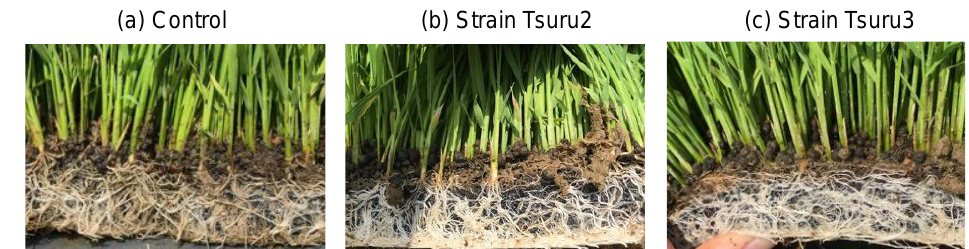
Figure 1. The roots of the rice seedlings before planting in the paddy field (1 month after sowing). ( a ) Control without bio-priming, ( b ) bio-primed with strain Tsuru2, ( c ) bio-primed with strain Tsuru3.